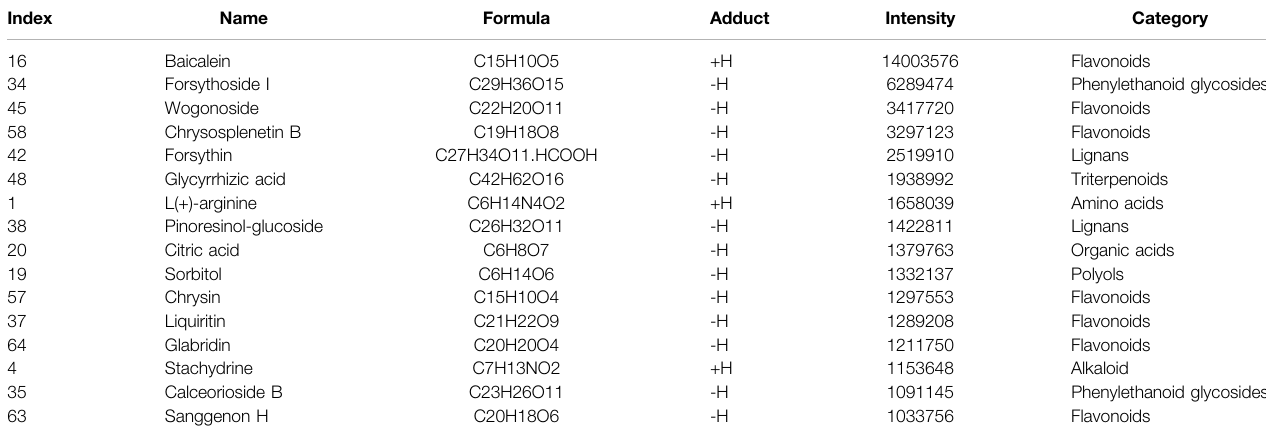
TABLE 2 | The chemical components with relative high abundance in QFYD detected by